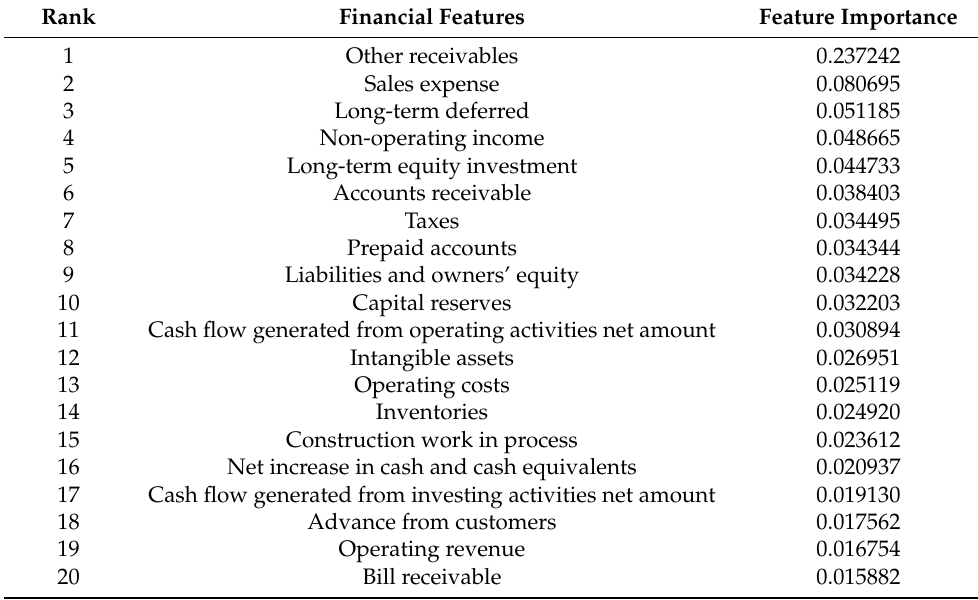
Table 2. Feature importance of the top 20 important financial variables in the CT-XGBoost